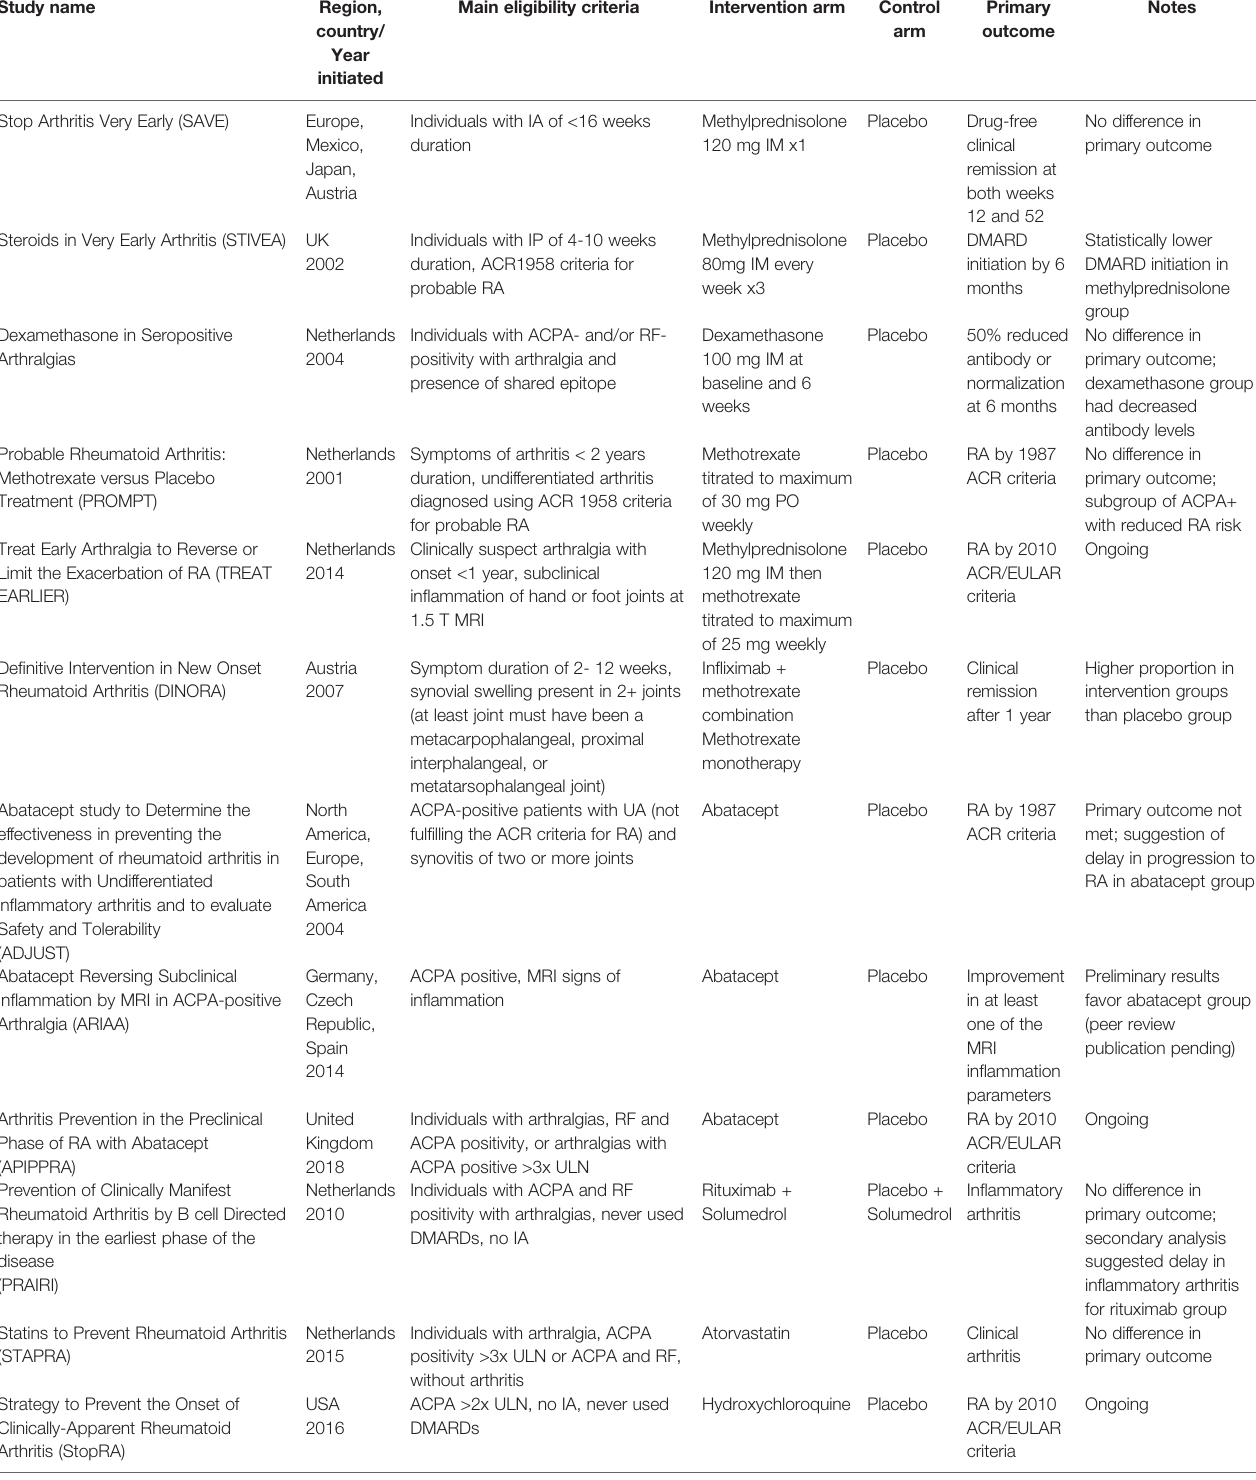
TABLE 2 | Selected clinical trials investigating rheumatoid arthritis